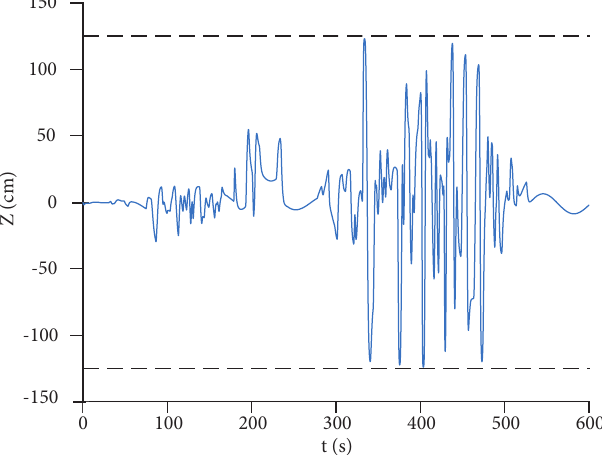
Figure 8. Overview of the Z-axis washout fi lter output during the performed fl ight.